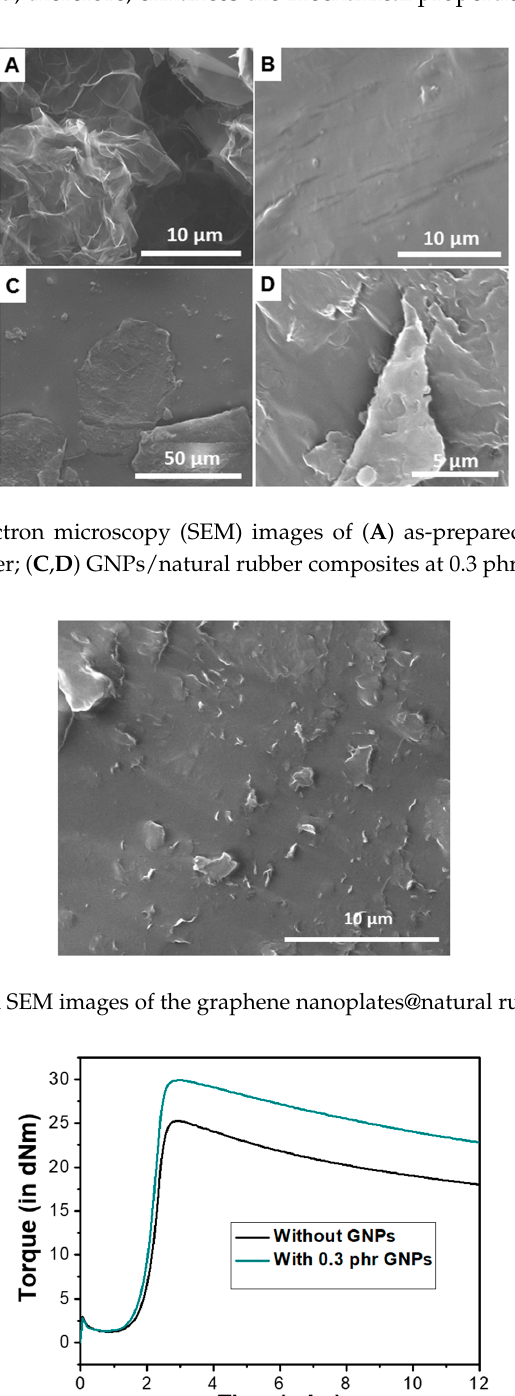
Figure 4. Torque-time curves of natural rubber composites without (black curve) and with (green curve) 0.3 phr GNPs content.